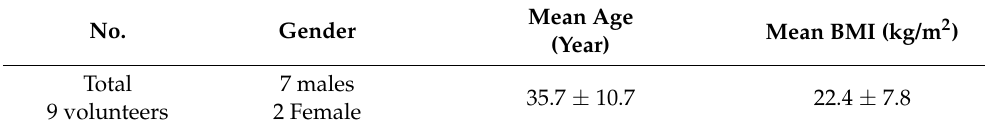
Table 2. Participant information ( n = 9).